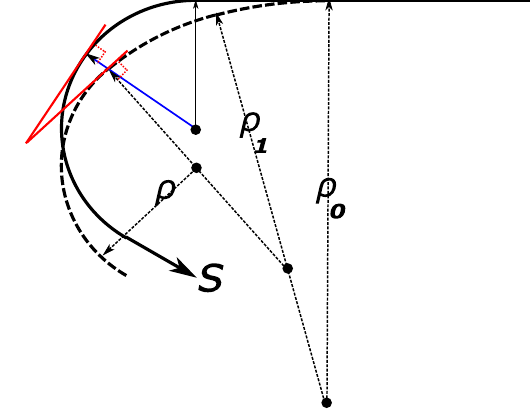
FIG. 9. Illustration of the difference between the particle orbit and the design orbit at the dipole entrance. The bold line represents the design orbit, and the thick dashed line represents the particle trajectory. The curvature of the particle trajectory decreased step by step. Initially, ρ 0 ¼ 3 ρ , then ρ 1 ¼ 2 ρ , and finally reaches the design curvature ρ . The three large dots correspond to the origins of the three curvatures. The blue line indicates the coordinate s where the particle orbit curvature finally becomes ρ . Red lines are tangent to the particle and design orbit at s .